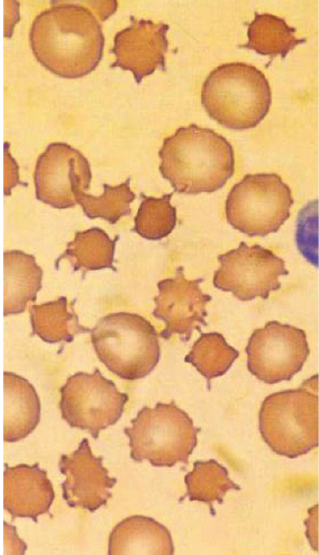
Figure 1 – The spiked red blood cells (acanthocytes) on the peripheral